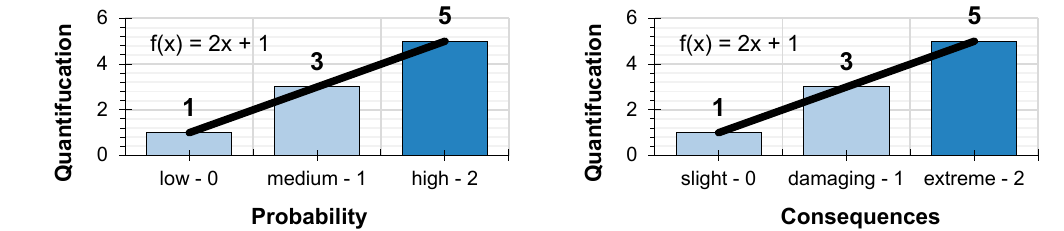
Figure 2. Quantification of the probability and consequences.